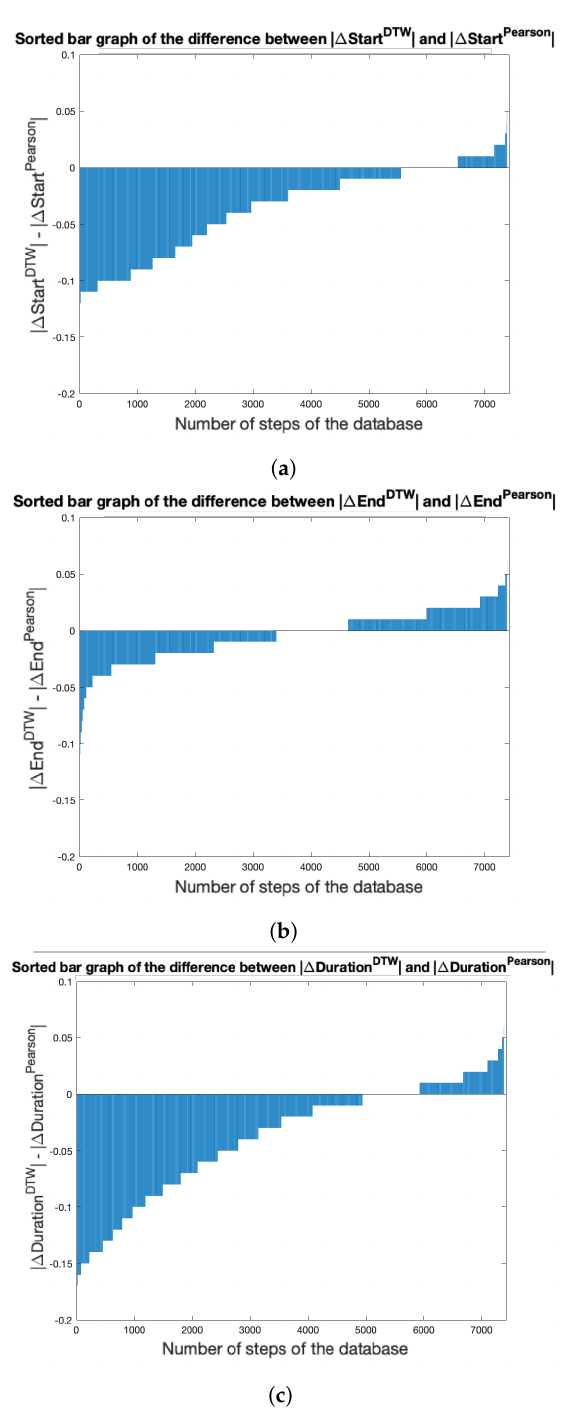
Figure 10. For strategy S5, sorted bar graph of the difference between the 7414 ( a ) ∆ Start, ( b ) ∆ Start and ( c ) ∆ Duration absolute errors obtained with the DTW distance criterion, and those obtained with the Pearson coefficient